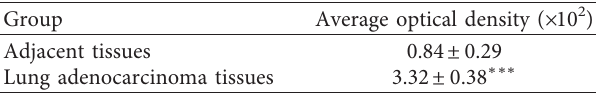
Table 1: Average optical density values of LASP1 protein ex- pressions by immunohistochemistry staining in human nonma- lignant adjacent tissues and lung adenocarcinoma tissues ( n �